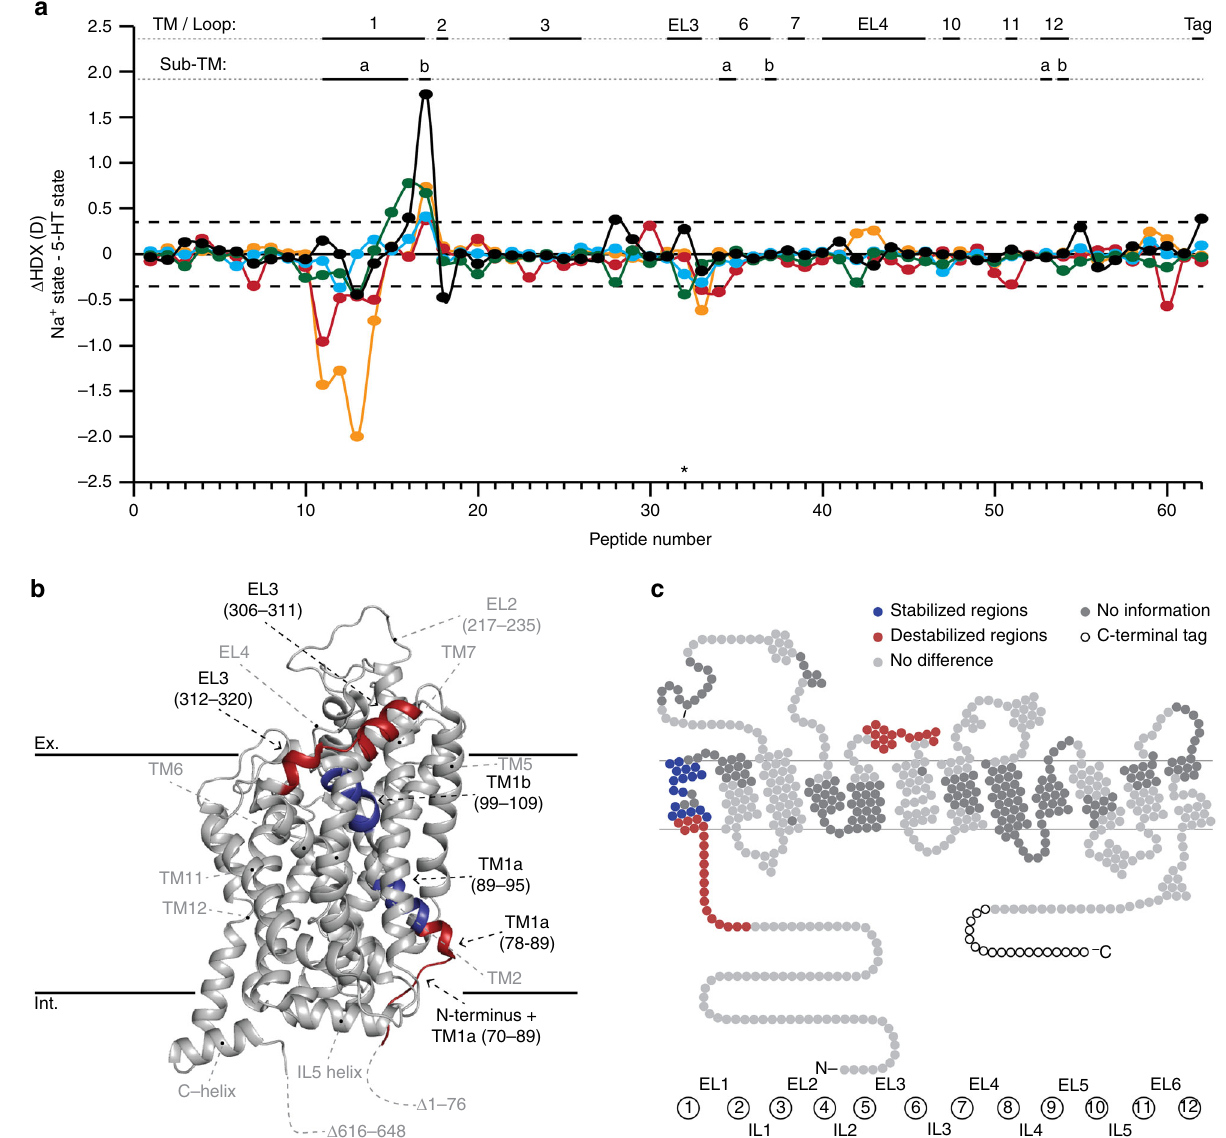
Fig. 3 Comparison of the HDX of hSERT in the presence of Na + and 5-HT with Na + . a A difference plot illustrating the difference in HDX between the Na + and 5-HT states for the 62 peptides identi fi ed from hSERT over the measured time points (orange — 0.25 min; red — 1 min; cyan — 10 min; green — 1 h; black — 8 h). Positive and negative values indicate decreased or increased HDX, respectively, when hSERT is in the presence of 5-HT and Na + compared to Na + only. The peptides are arranged according to their position from the N- to C-terminal (Supplementary Table 1). The dotted line (±0.35 D ) indicates 95% CI as a threshold for signi fi cance. Structural motifs in hSERT are indicated along the x -axis above the plot. b , c Regions showing signi fi cant increase (red) or decrease (blue) in dynamics (i.e., HDX) in the presence of 5-HT and Na + compared to Na + alone are plotted on the crystal structure (PDB ID: 5i75) ( b ) and a snake diagram ( c ) of hSERT. Regions coloured grey indicate insigni fi cant difference in HDX between the two experimental states (light grey) or regions not covered by peptides (dark grey). Regions showing signi fi cant difference in HDX are indicated with black text with residue location in the structural model. Structural elements located on the front side of the crystal structure but do not show signi fi cant difference in HDX, are indicated with grey text without residue information for orientation and regions not resolved or truncated in the crystal structure are indicated as dotted lines. Black solid lines at the top and bottom of the structural model show an approximation of the extracellular (Ex.) and intracellular (Int.) boundaries of the membrane, respectively. Source data for the HDX data are provided as a Source data fi